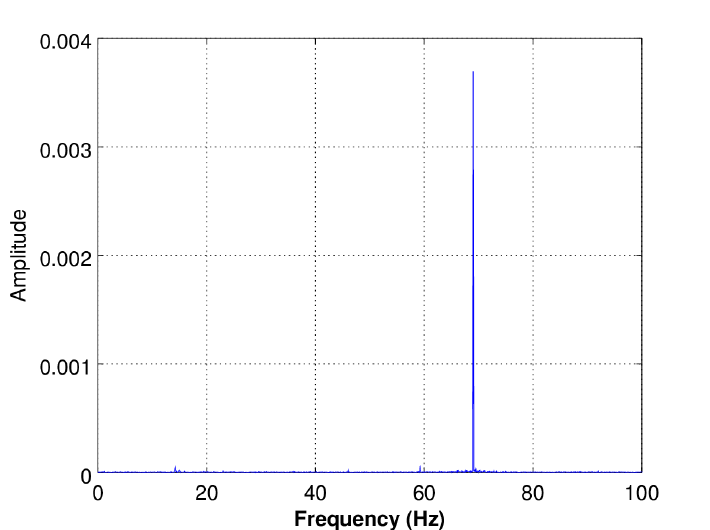
Figure 13. The result of the FFT analysis of the tracking error for 23 Hz sinusoidal reference when the actuator is controlled only by u f [ k ] . It is apparent that the error signal includes only the third harmonic